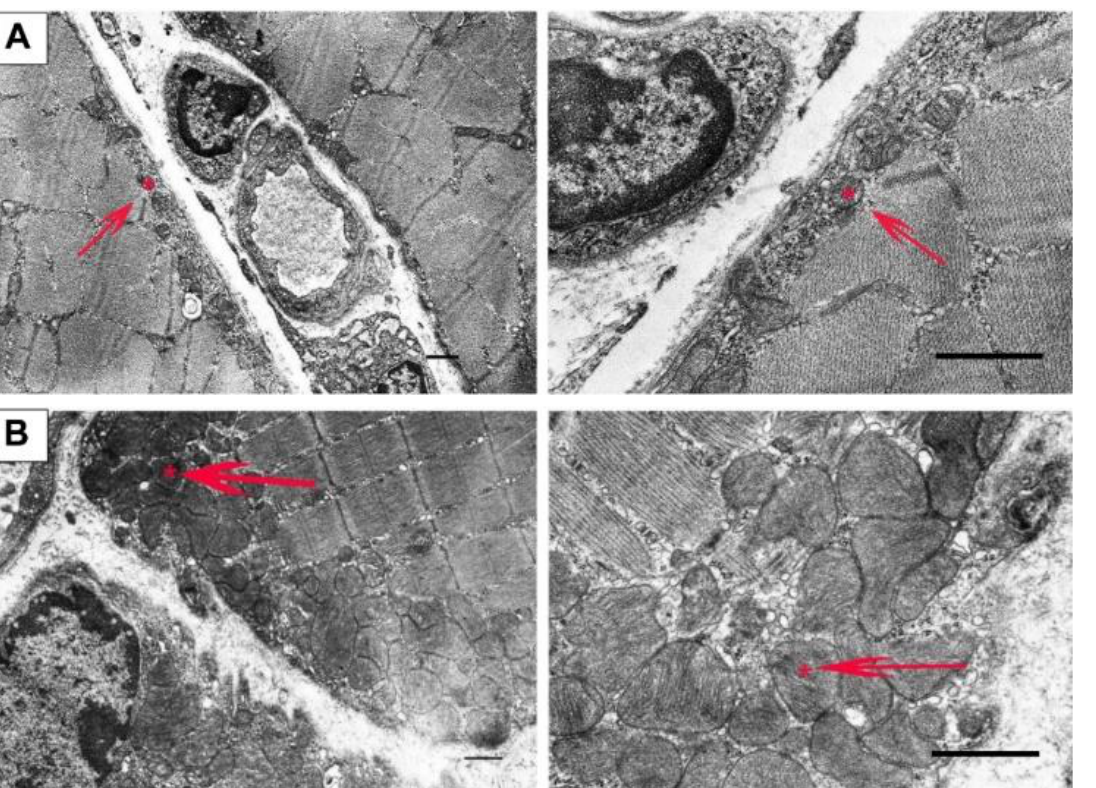
Figure 4. Representative transmission electron micrographs of mouse skeletal muscle (quadriceps) sections from WT ( A ), WT+U ( B ), mdx ( C ), and mdx +U ( D ) groups showing the quality of the ultra- structure of the subsarcolemmal population of mitochondria (highlighted by red arrows). An aster- isk marks the same mitochondria at low and high magnification. The bars are equal to 1 μm.